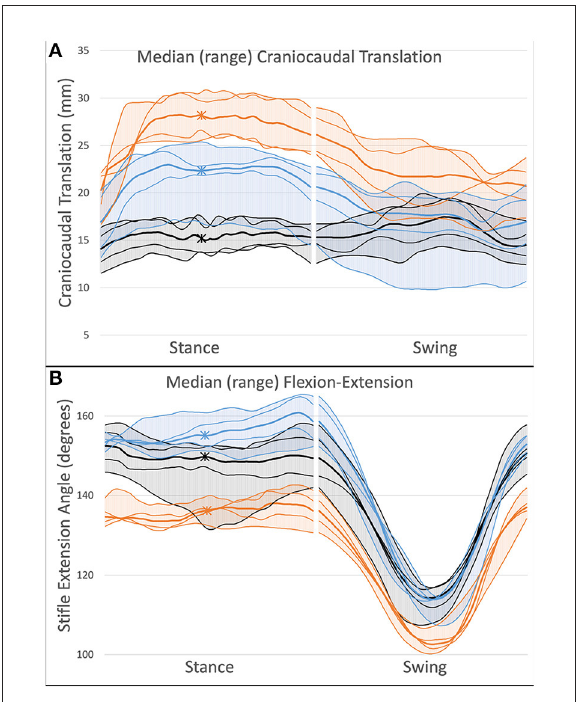
FIGURE1 Kinematic outcomes after CBLO in 4 dogs. Increased y-value indicates cranial tibial translation (A) or stifle extension (B) . X-axis represents progression through the gait cycle with the break in data indicating the transition from stance to swing phase. Asterisks mark mid-stance phase. Orange line, Preoperative; Blue line, Post-CBLO; Black line, Control. Thick lines represent median (range) values and thin lines represent individual dog values. CBLO resulted in incomplete mitigation of cranial tibial translation (A) and increased extension angle (B) during stance